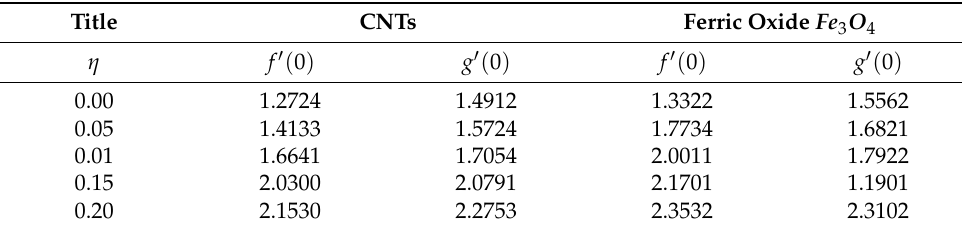
Table 4. The comparative study of CNTs and ferric-oxide nanoparticles on the velocity field.